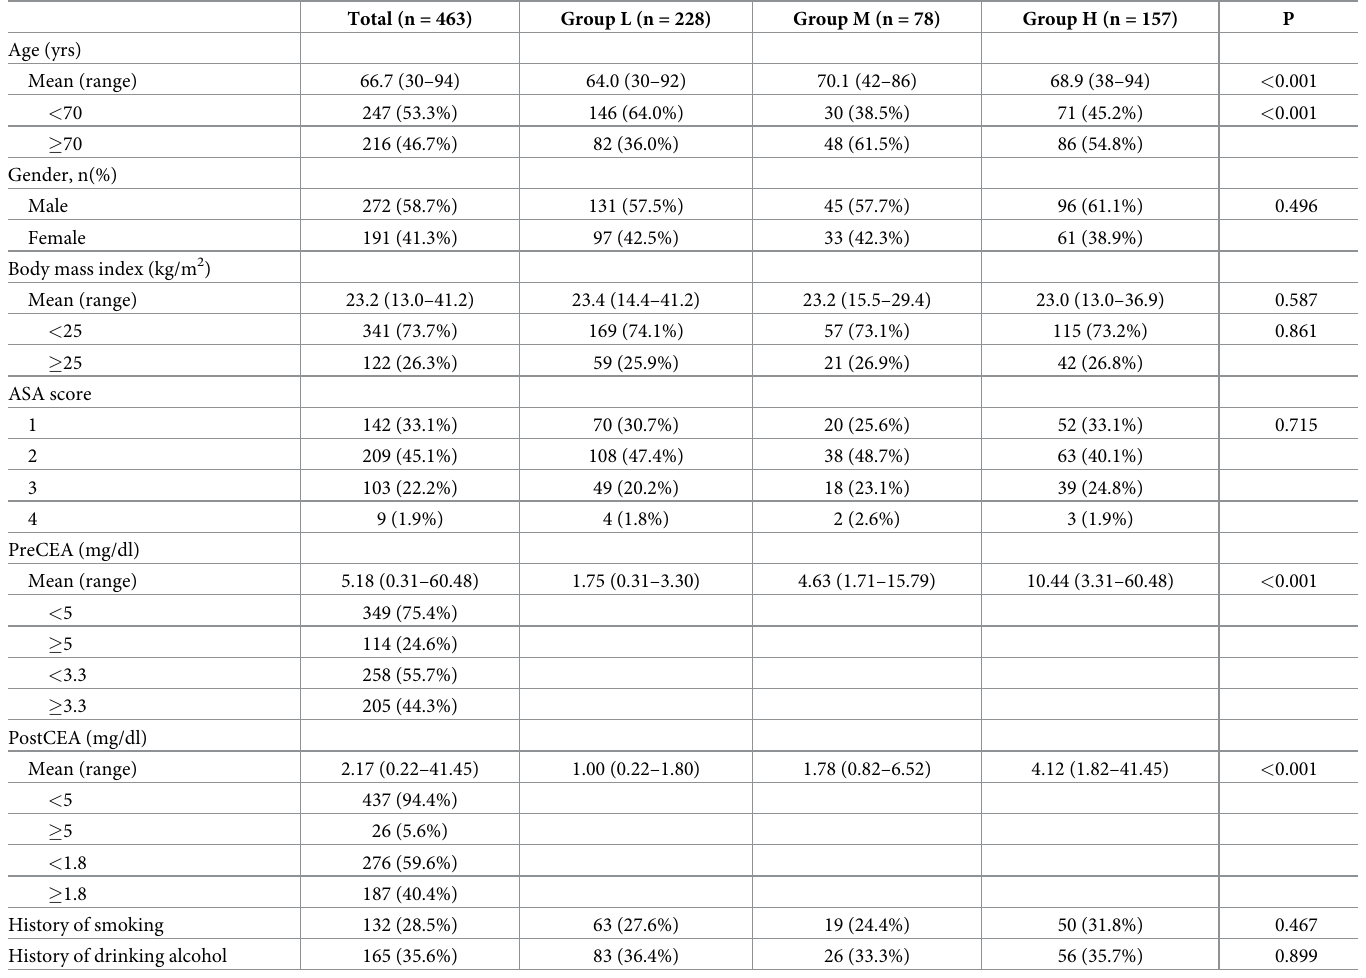
Table 1. Demographics of the patients with low risk stage IIA colorectal cancer patients.